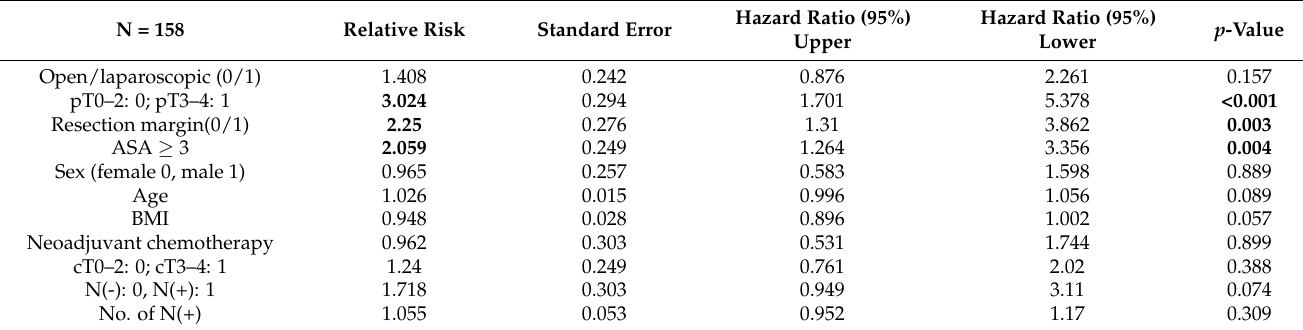
Table 2. Multiparameter analysis of ORC vs. LRC.